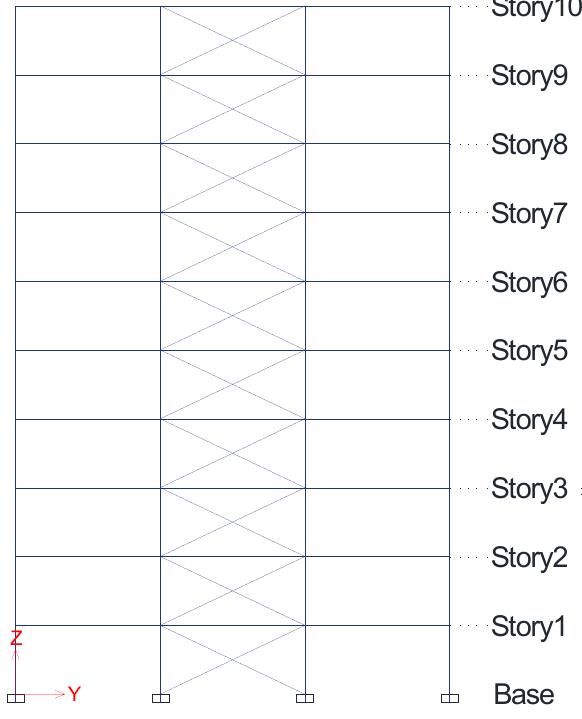
Figure 3. 10 Story building frame in the Etabs software.